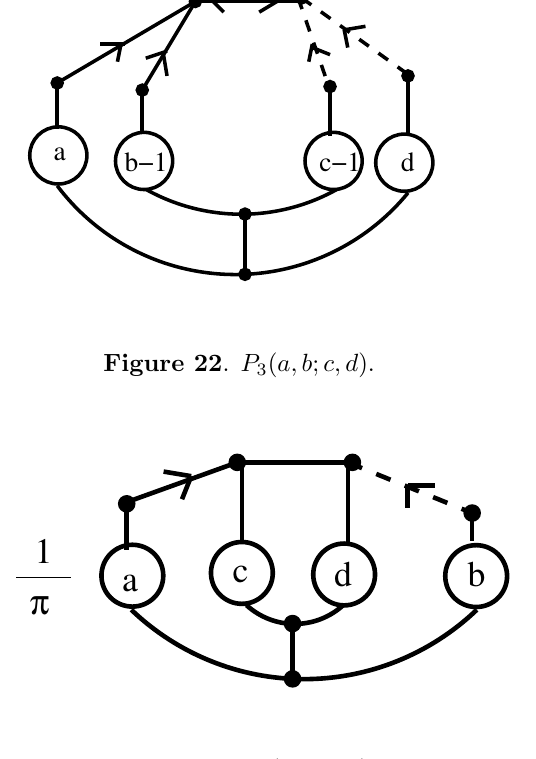
Figure 23 . Q 3 ( a; b ; c; d